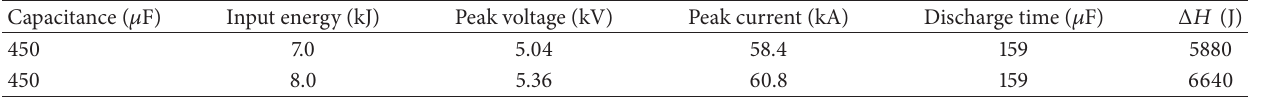
Figure 7: (a) Typical discharge curve measured current and voltage on oscilloscope and (b) typical power curve versus discharge time (discharge condition: 450 𝜇 F, 7.0 kJ). Table 2: Peak voltage, peak current, discharge time, and heat generated ( Δ𝐻 ) during a